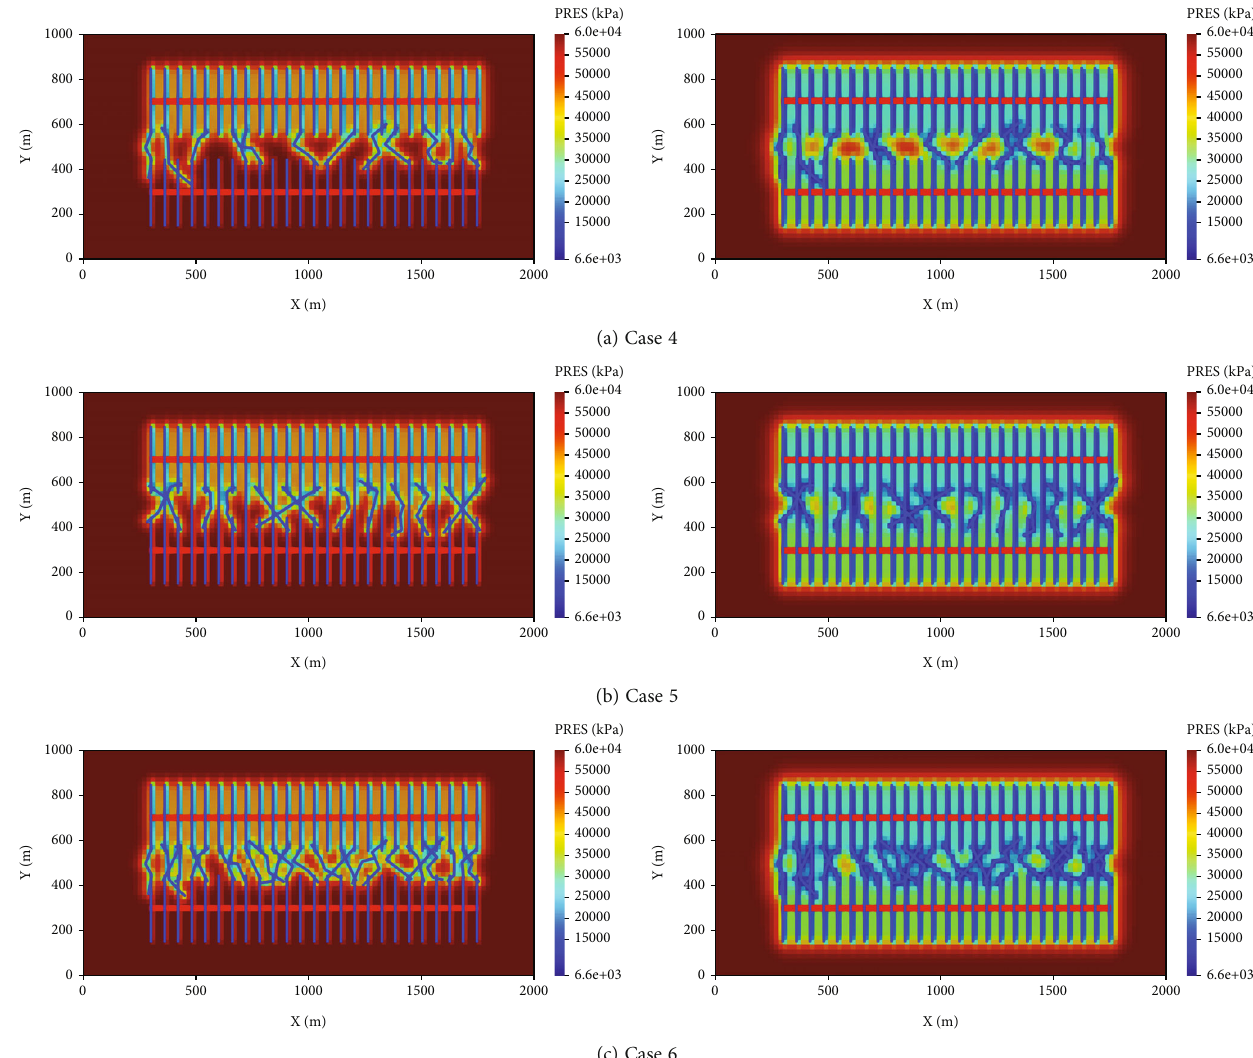
Figure 4: Pressure distribution of two MFHWs considering both hydraulic fractures and natural fractures. (a) Two horizontal wells are connected through partial natural fractures. (b) Two horizontal wells are connected through both hydraulic fractures and natural fractures. (c) Two horizontal wells are connected through numerous natural